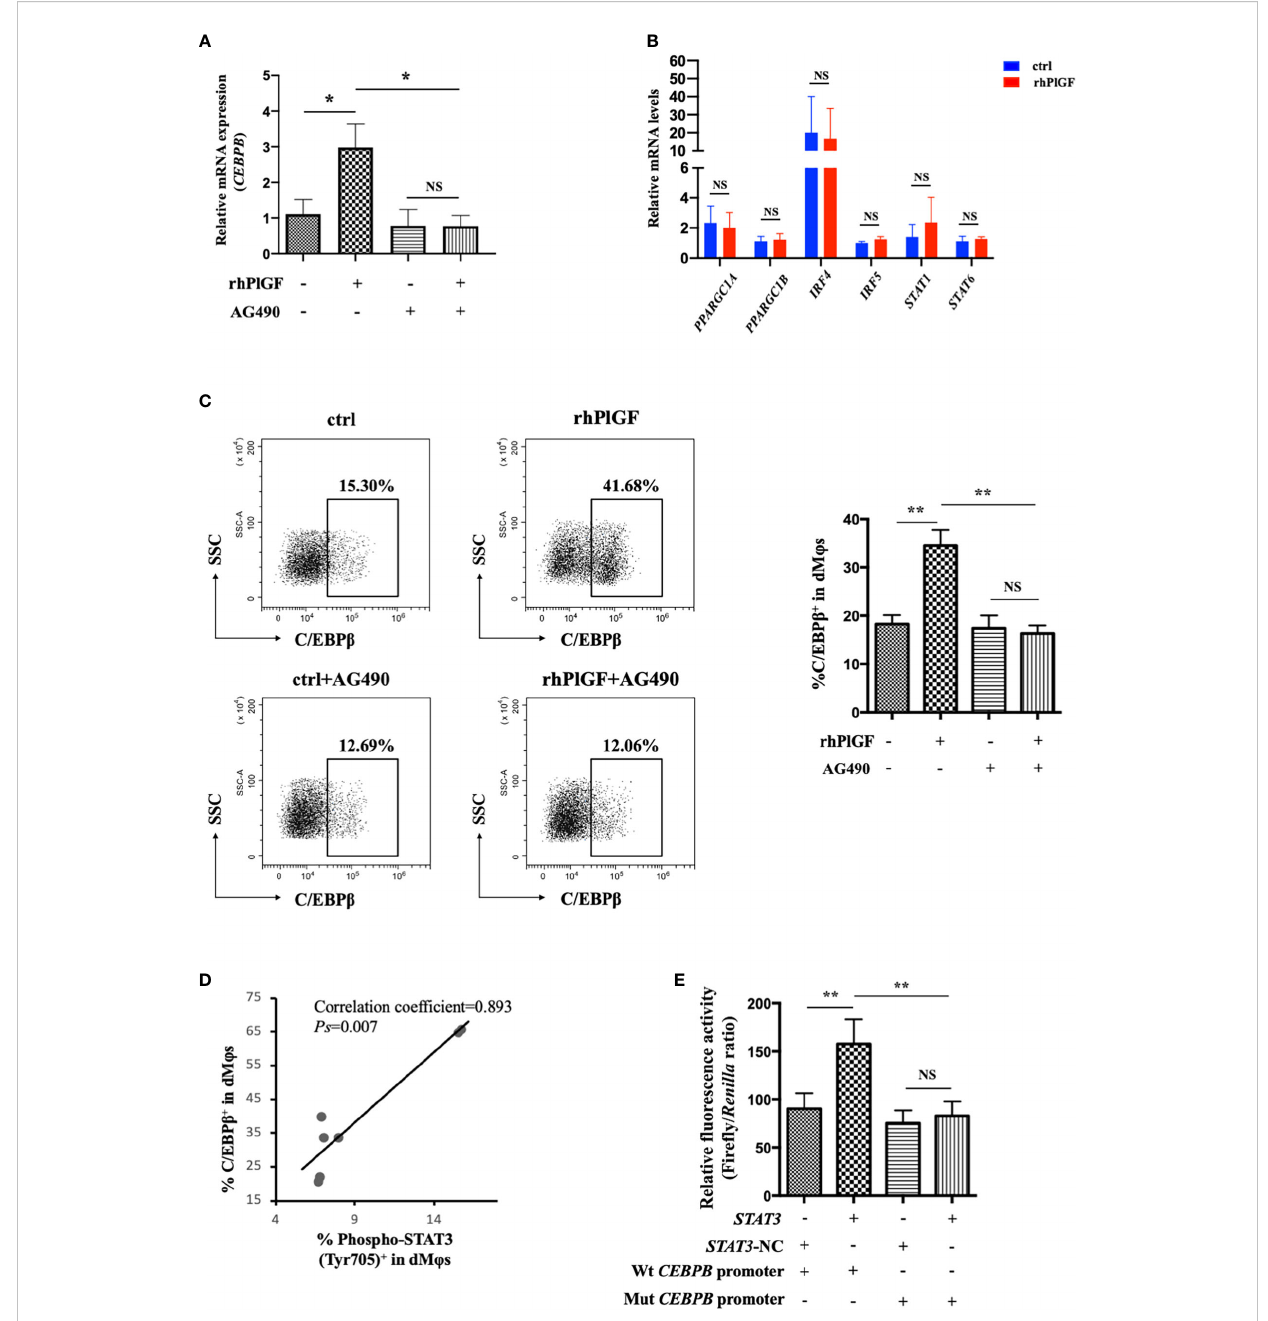
FIGURE 4 PlGF promoted the M2-like polarization via the STAT3-C/EBP b signaling pathway. (A) The qRT-PCR analysis of CEBPB expression in decidual macrophages (dM j s) after 48 hour treatment with recombinant human PlGF (rhPlGF, 100 ng/mL) following 1 hour pretreatment with AG490 (10 m M) (4 independent experiments). (B) Relative mRNA levels of PPARGC1A, PPARGC1B, IRF4, IRF5, STAT1 , and STAT6 in dM j s after 48 hour treatment with rhPlGF (100 ng/mL) (3 independent experiments). (C) The expression level of C/EBP b in dM j s by FCM analysis after 48 hour treatment with rhPlGF (100 ng/mL) following 1 hour pretreatment with AG490 (10 m M) (9 independent experiments). (D) The Pearson correlation analysis for the levels of C/EBP b expression and STAT3 phosphorylation at Tyr 705 in rhPlGF-polarized (100 ng/mL) dM j s (n=7). (E) STAT3-overexpression or vector plasmids, wild-type or mutant CEBPB promoter-reporter plasmids, and TK promoter-Renilla plasmids were co-transfected in the 293T cells for 48 hours. The luciferase activity was measured and normalized to Renilla luciferase (9 independent experiments). Data were analyzed by paired t-test or Wilcoxon matched-pair signed-ranks test, and shown as mean ± SEM. * P < 0.05, ** P < 0.01, and NS no statistically difference. ctrl, control; Mut, mutant; NC, negative control; Wt,